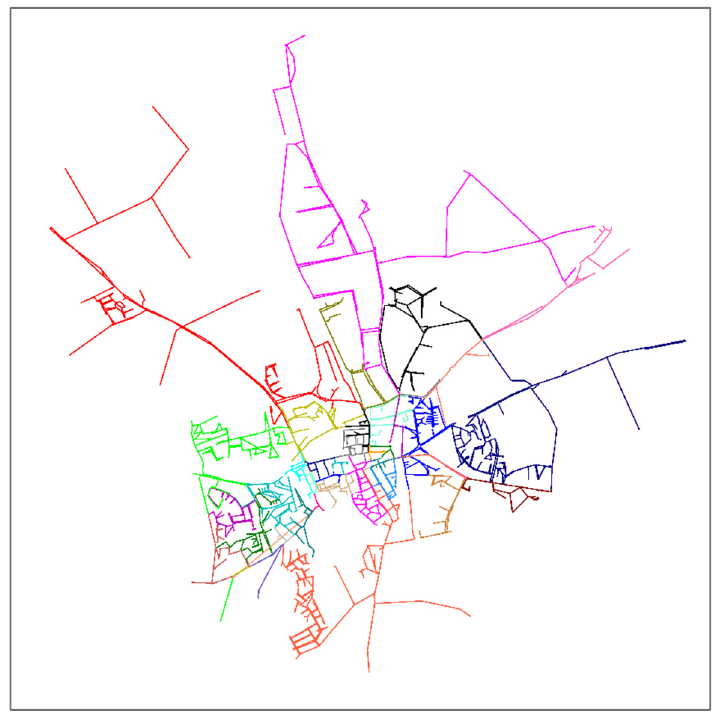
Figure 6. Network model of City X: Each color identifies a different double-fed cluster.